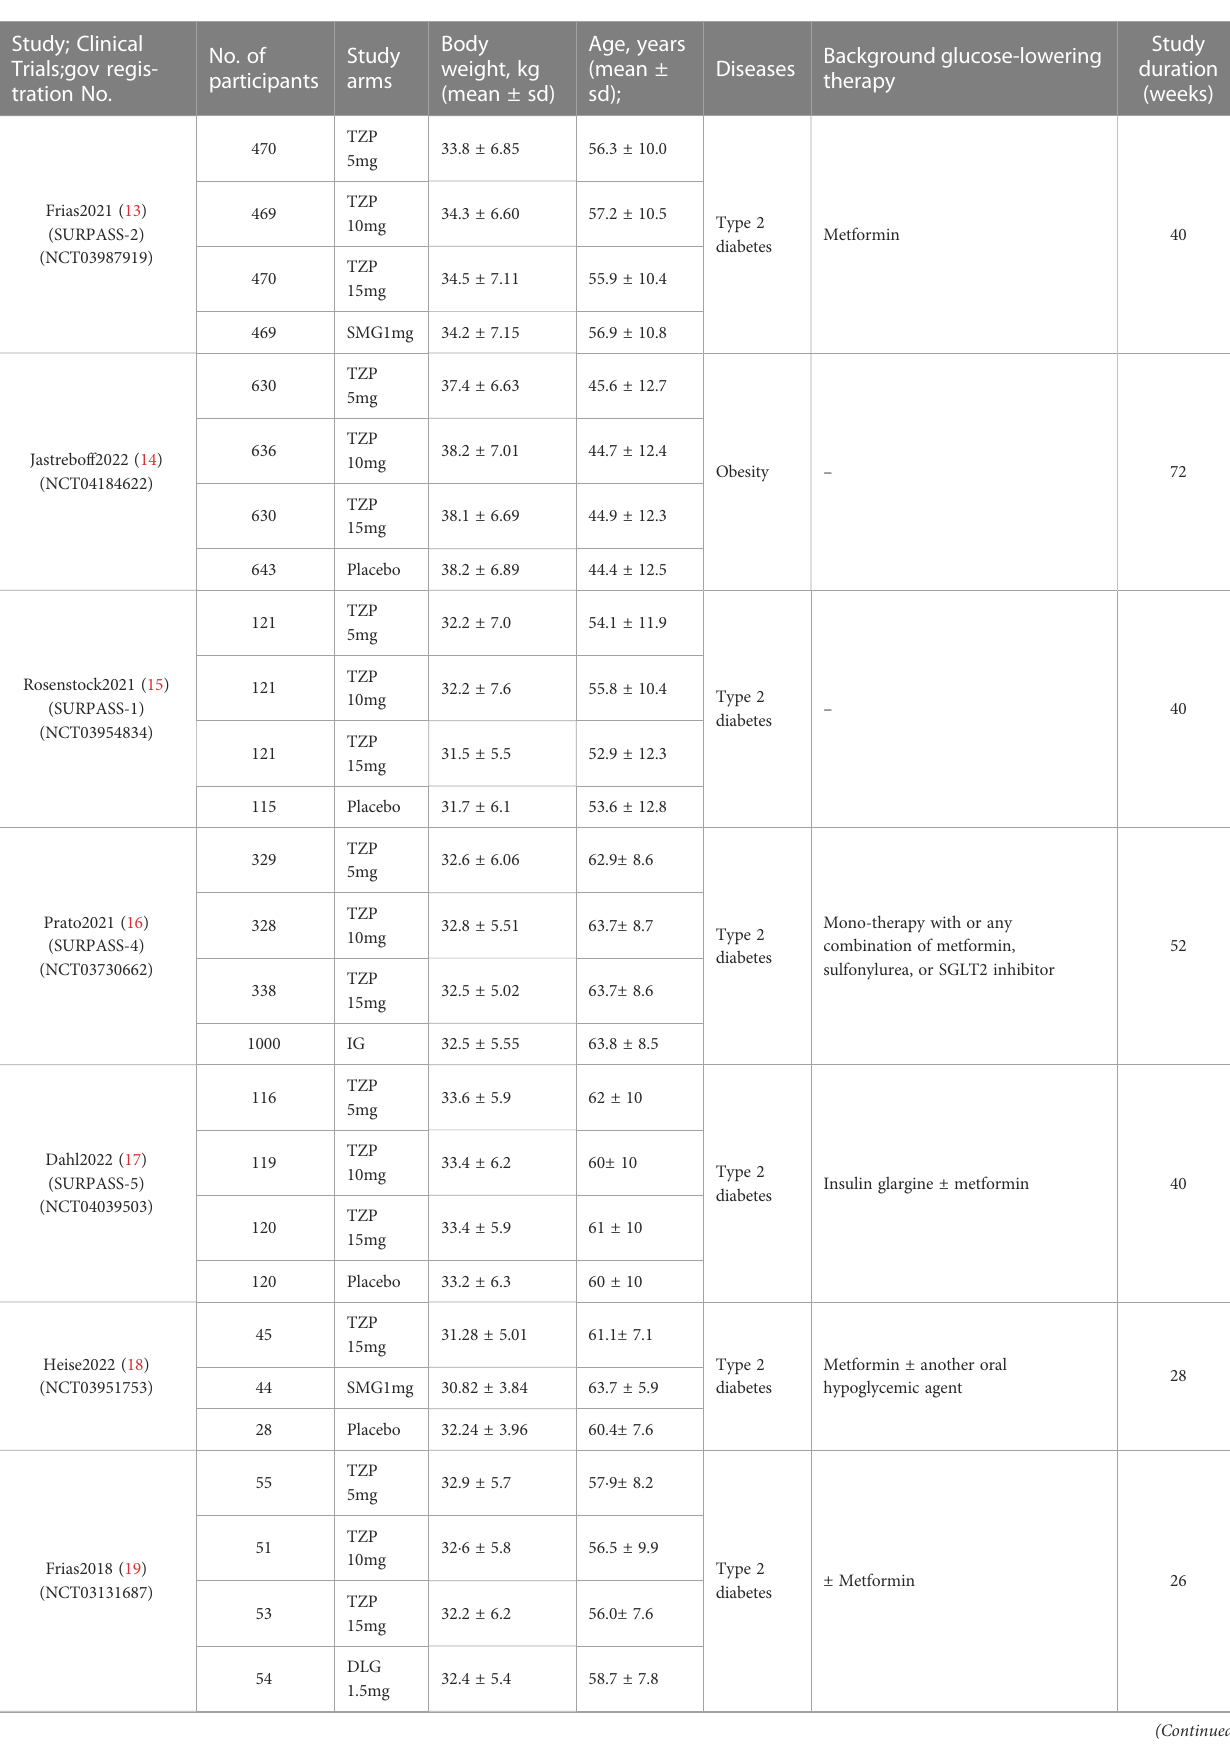
TABLE 1 Study-level and participant baseline characteristics of included RCTs. Study; Clinical Trials;gov regis- tration No.